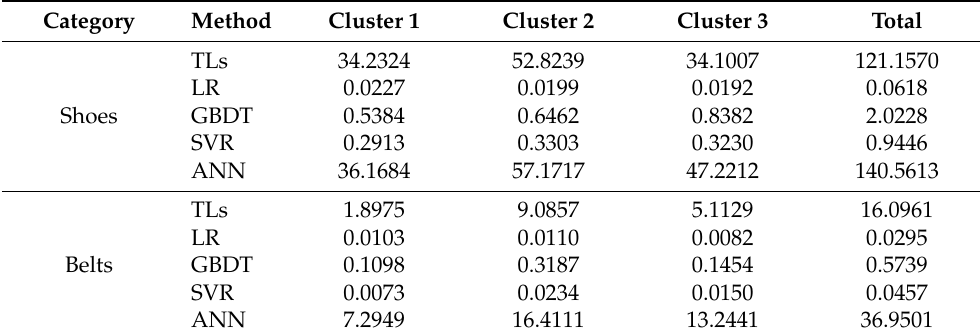
Table A1. Runtimes of the TLs model and benchmark models.